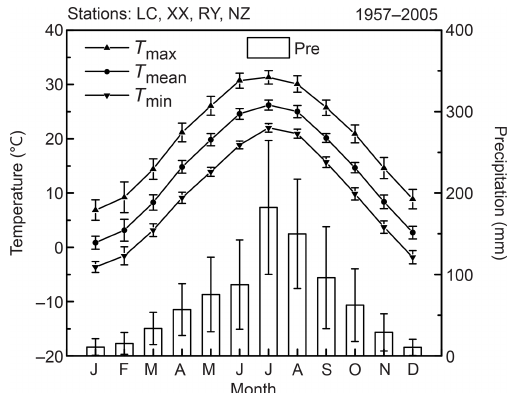
Figure 2. Monthly maximum, mean, minimum temperatures ( T max , T mean , T min ), and total precipitation (Pre) averaged from the four selected meteorological stations (LC: Luanchuan, XX: Xixia, RY: Ruyang, and NZ: Nanzhao) during the period 1957–2005. Error bar denotes ± one standard